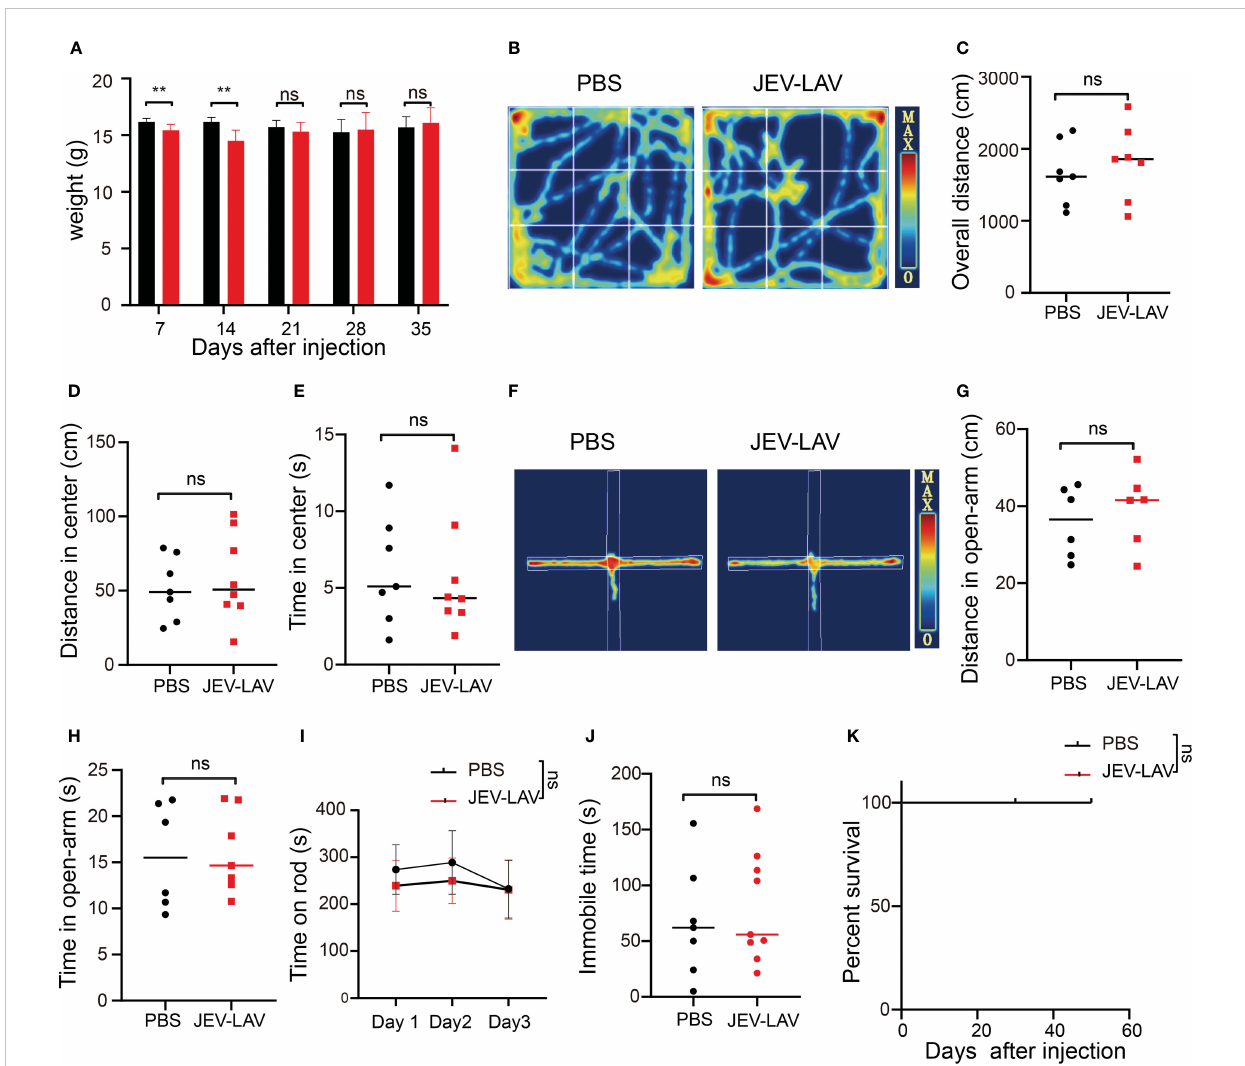
FIGURE 1 Safety evaluation of intracerebral administration of JEV-LAV in the experimental mice. (A) Weight changes in the mice after 2 weeks of injection. (B – J) C57BL/6J mice were intracerebrally inoculated with 1.6 × 10 6 PFU (consistent with the therapeutic dose) JEV-LAV, while PBS injection served as control. The clinical signs and survival of the animals were monitored daily. Behavioral testing was conducted after 2 weeks. (B) The motion track of the mice in the open fi eld test. (C) Overall distance covered by the mice in the open fi eld test. (D) Movement distance in the center of the mice in the open fi eld test. (E) Residence time in the center of the mice in the open fi eld test. (F) The motion tracking of mice in the elevated plus-maze test. (G) The overall distance of mice in the open arm. (H) The residence time of mice in the open arm. (I) Total time of mice on the rod in the rota- rod teat. (J) Immobile time of mice within 5 min of tail suspension in the tail-suspension test. (K) Survival (n = 8/group). *P < 0.05; **P < 0.01; ***P < 0.0001; ns, no statistical signi fi